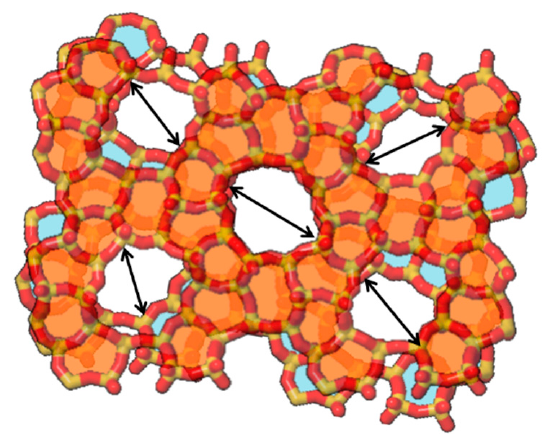
Figure 8. Stacking of two MFI-type zeolite structure sheets viewed from the b -axis with 5-degree rotation.